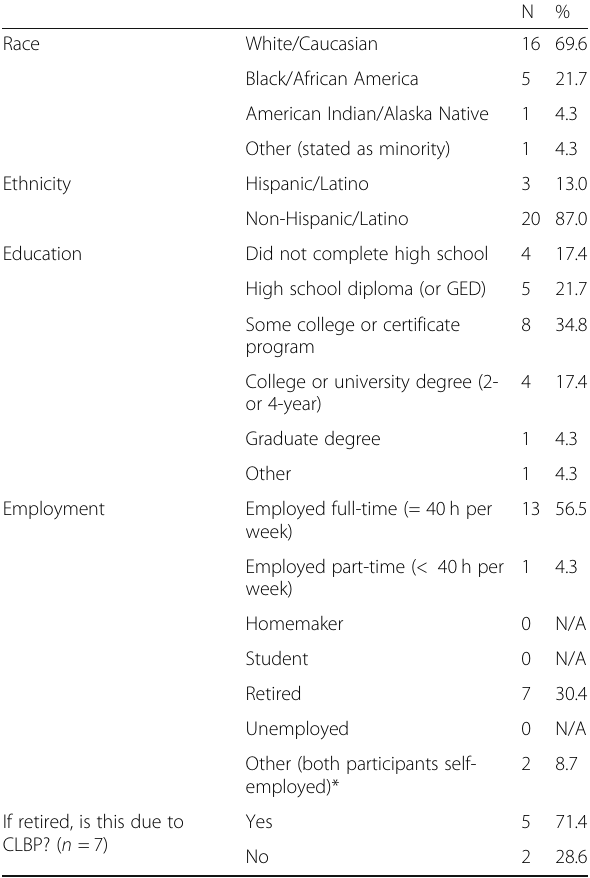
Table 1 Additional demographic and health information